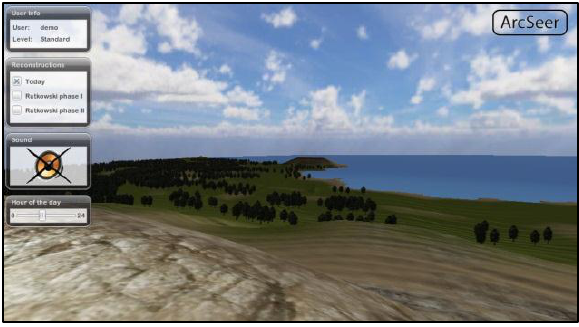
Figure 10: Accessing online ArcRange data resources in the ArcSeer Priniatikos Pyrgos